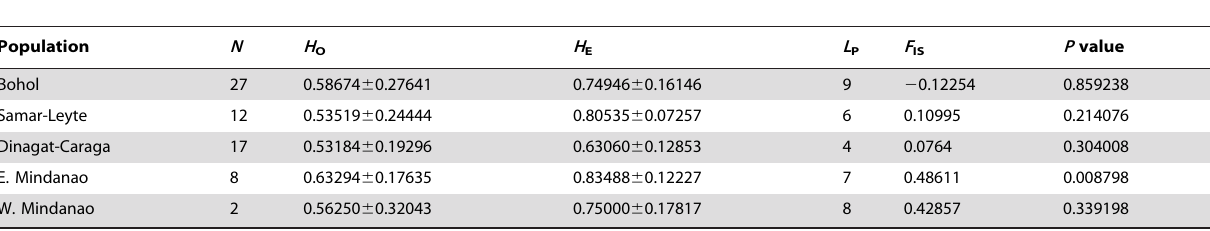
Table 2. Microsatellite variation in 66 individuals of Tarsius syrichta from 17 localities (Fig. 2).